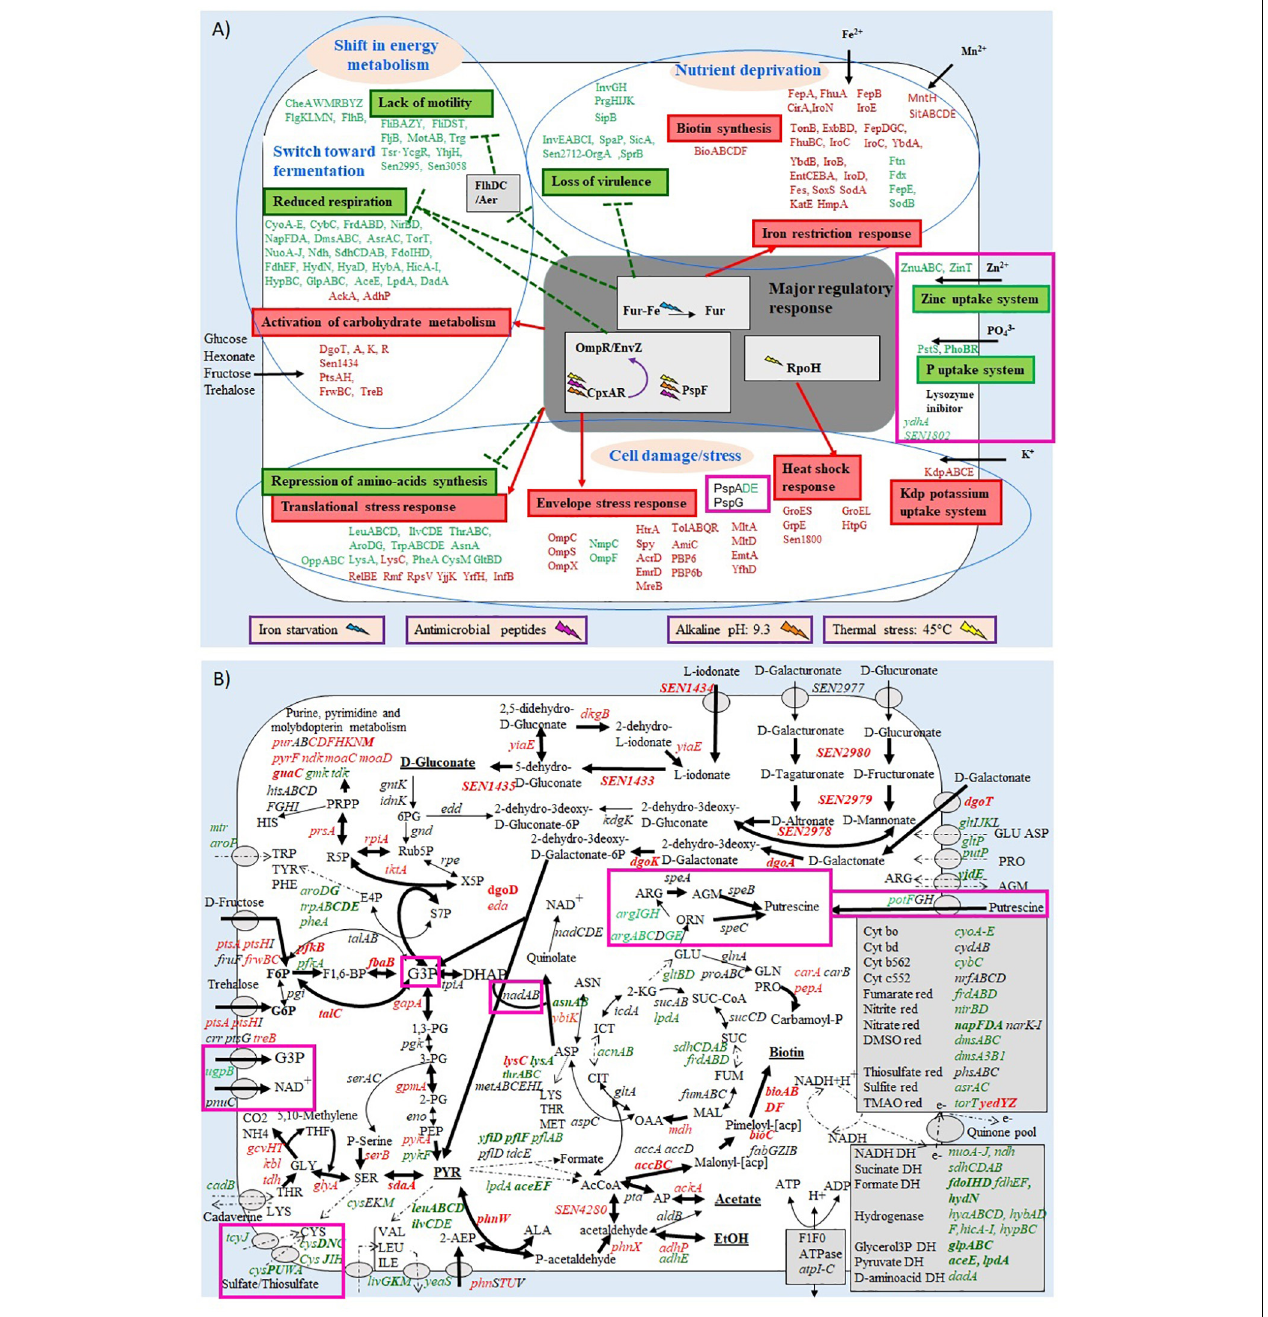
FIGURE 3 | Summary of the effect of S. Enteritidis 45 min exposure to EWF (A,B) on selected metabolic pathways. Transporters are symbolized by gray ovals. Up-regulated, down-regulated, and non-regulated genes are represented in red, green or black, respectively. Genes with a ≥ 4-fold change in expression are in bold. The metabolites predicted to be increased are underlined. Up-regulated, down-regulated and non-regulated pathways are represented by thick, broken, or fine arrows, respectively. Genes with different expression levels between the incubation in EWMM (from Baron et al., 2017) and in EWF are boxed in pink. Metabolic pathway data were obtained from KEGG